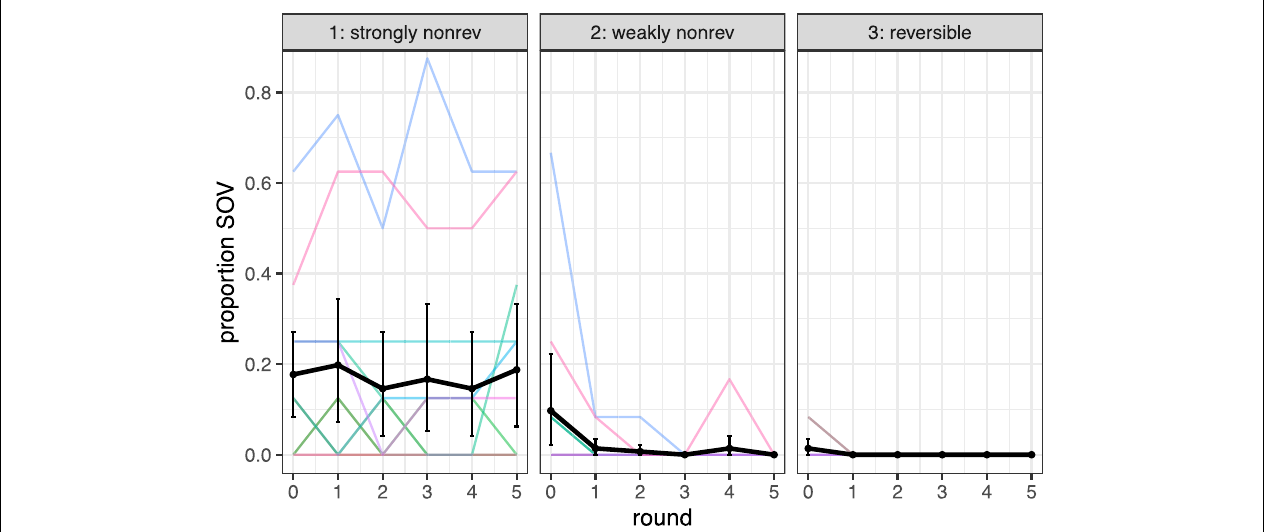
FIGURE 8 | Proportion SOV by round, for strongly non-reversible events (left), weakly non-reversible events (middle), and reversible events (right). Black lines indicate means, error bars are 95% CI’s, and colored lines represent dyads. In the analysis we compared the two non-reversible event types; the reversible events are included for